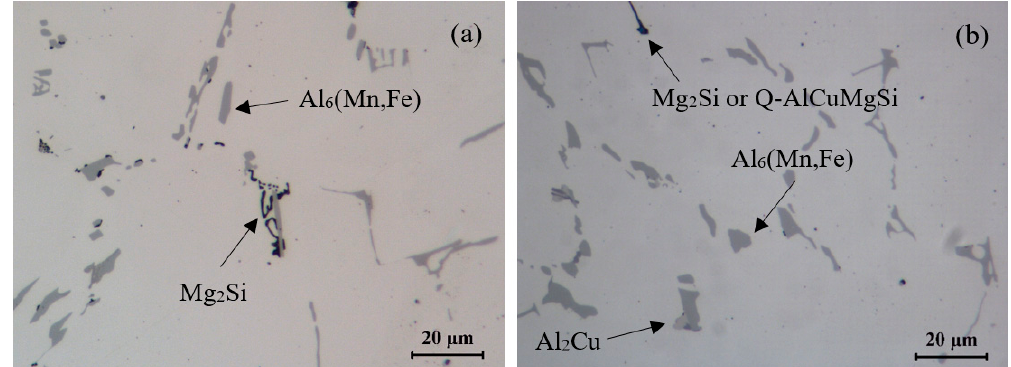
Figure 2. Typical as-cast microstructures of ( a ) DU0 alloy and ( b ) DU120 alloy.